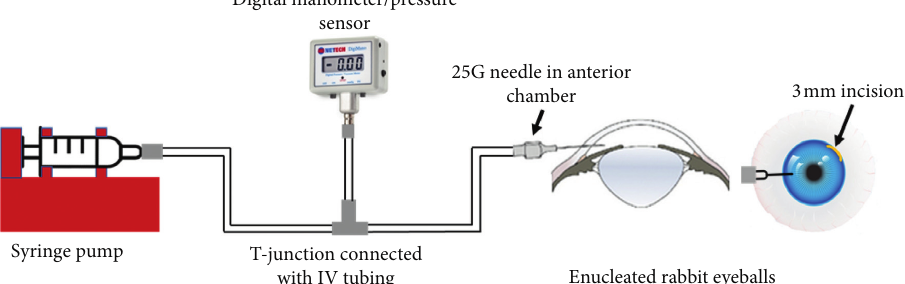
Figure 1: An illustration of the experimental model.